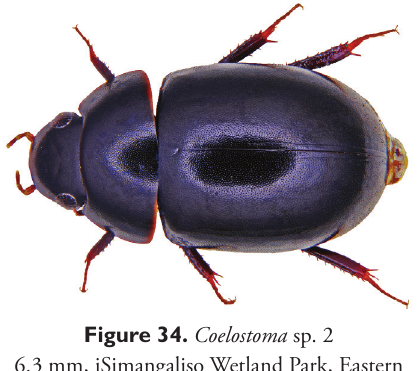
Figure 34. Coelostoma sp. 2 6.3 mm, iSimangaliso Wetland Park, Eastern Shores (site 23), February 2015 DT Bilton, MS Bird & R Perissinotto leg.